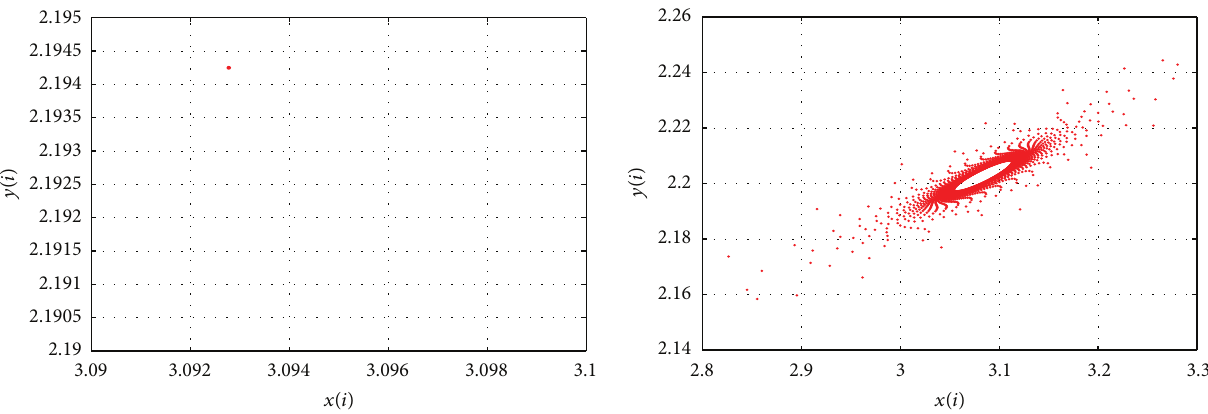
Figure 7: The portraits for several values of 𝐴 1 = 0.18 , 𝛿 = 5.3 , and 𝛿 = 5.335